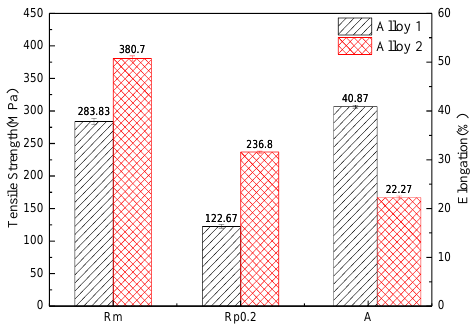
Figure 5. The mechanical properties of the extruded Al-5Mg